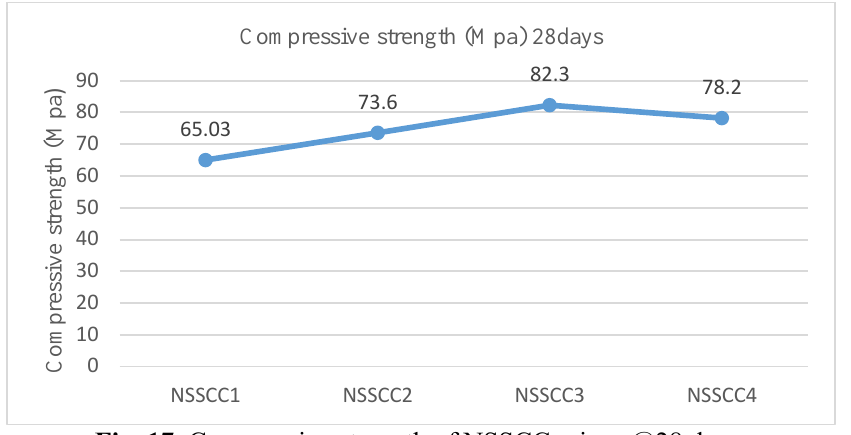
Fig. 17. Compressive strength of NSSCC mixes @28 days.